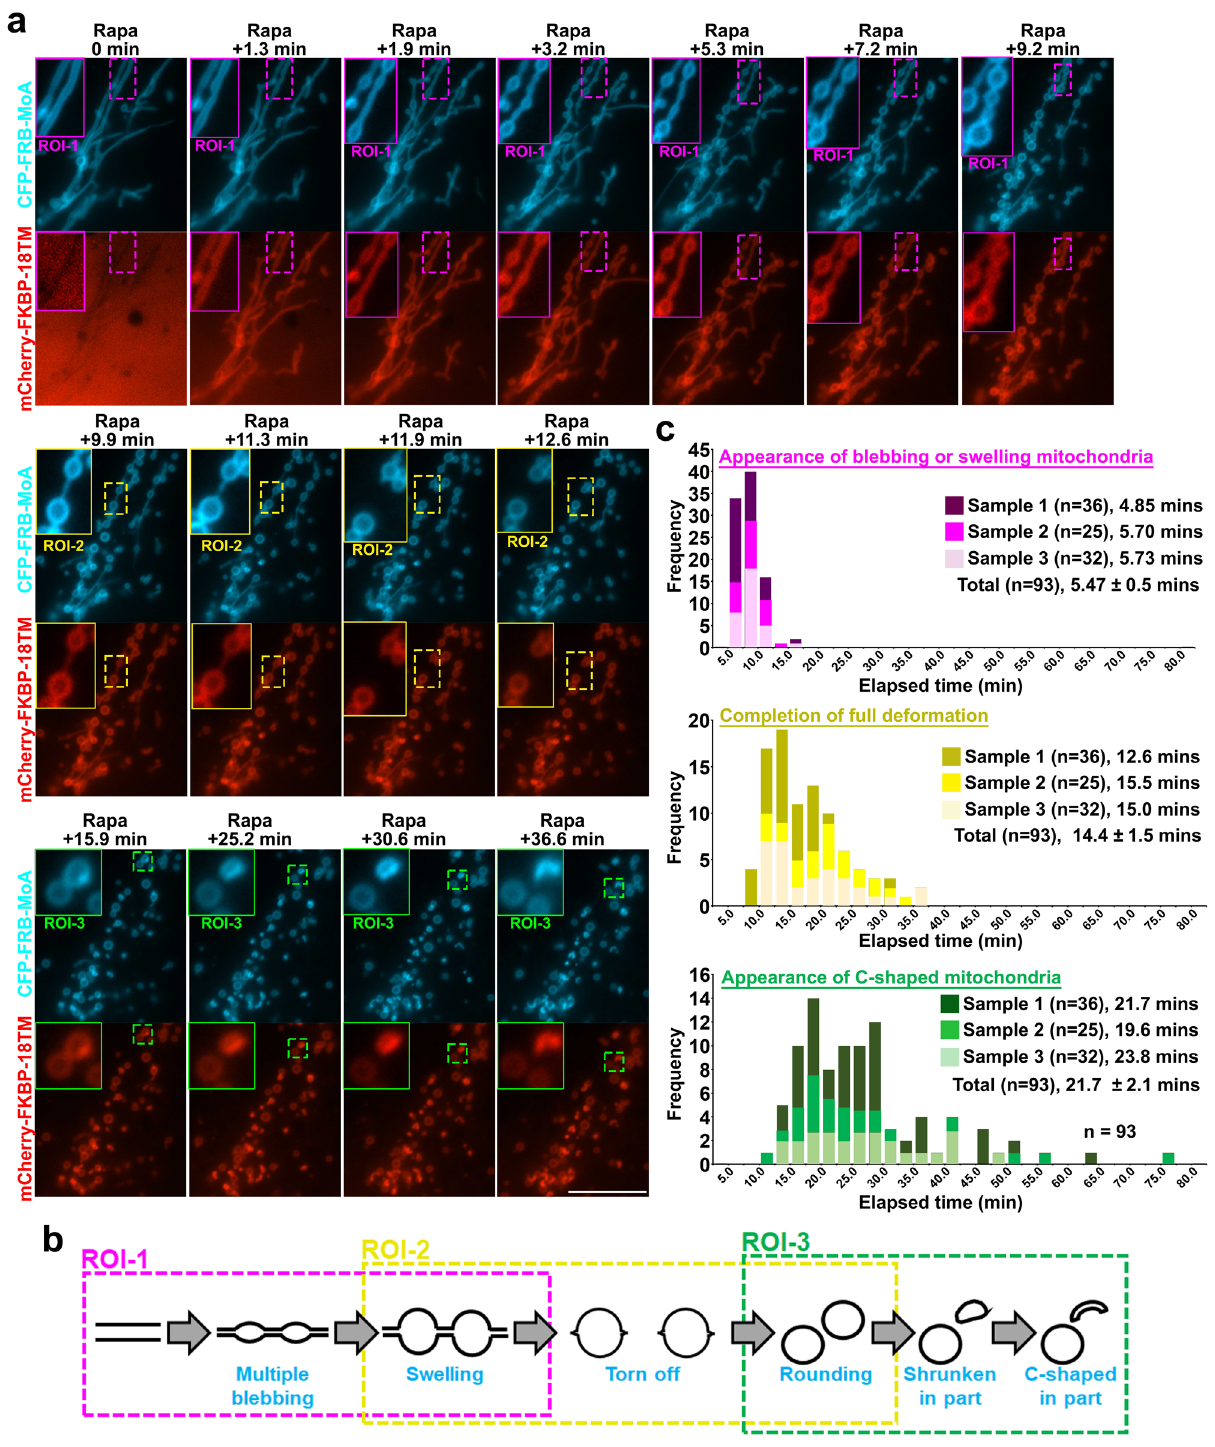
Fig.2|Kineticsofmitochondriamorphologicalchangesfollowinginductionof 18TM translocation. a Fluorescence images of cells expressing CFP-FRB-MoA (cyan) and mCherry-FKBP-18TM (red), indicating three-step morphological changes. ROI-1: Straight-form mitochondria changed into multiple blebbed structures (top panels). ROI-2: Blebs further swelled and fi nally torn off (middle panels). ROI-3: A part of rounding mitochondria changed into shrunken or C-shaped form (bottom panels). Scale bar = 10 μ m. The experiment was repe- ated at least three times. b Schematic illustration of the three-step deformation